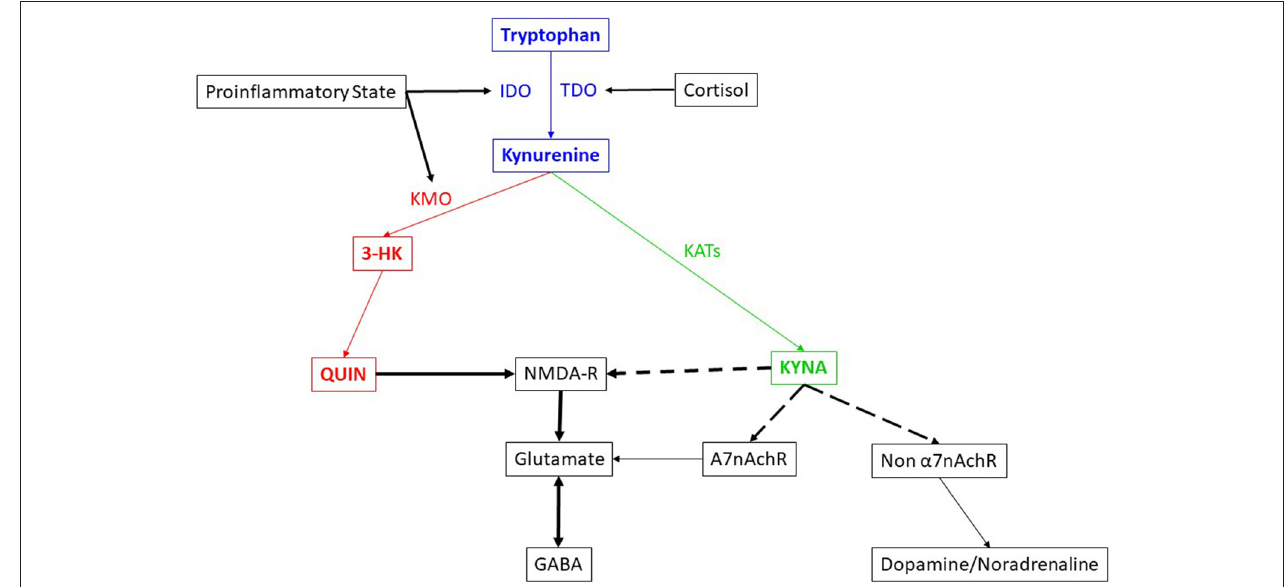
FIGURE 1 | Brief description of the kynurenine pathway and its interaction with other